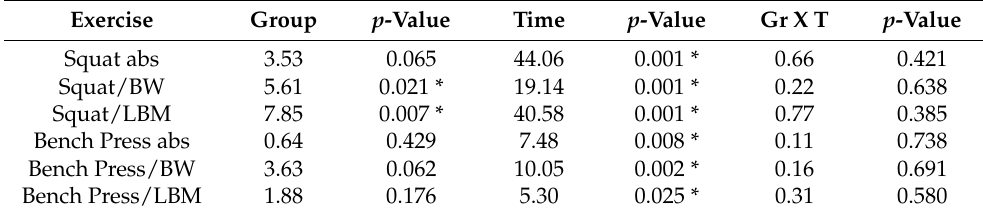
Table 6. Mean treatment effect and 95% confidence intervals (CI) between the ACC ( n = 14) and the PL ( n = 17) groups. Exercise Effect 95% CI p -Value Squat 5.62 [0.27, 10.96] 0.049 * Squat/BW